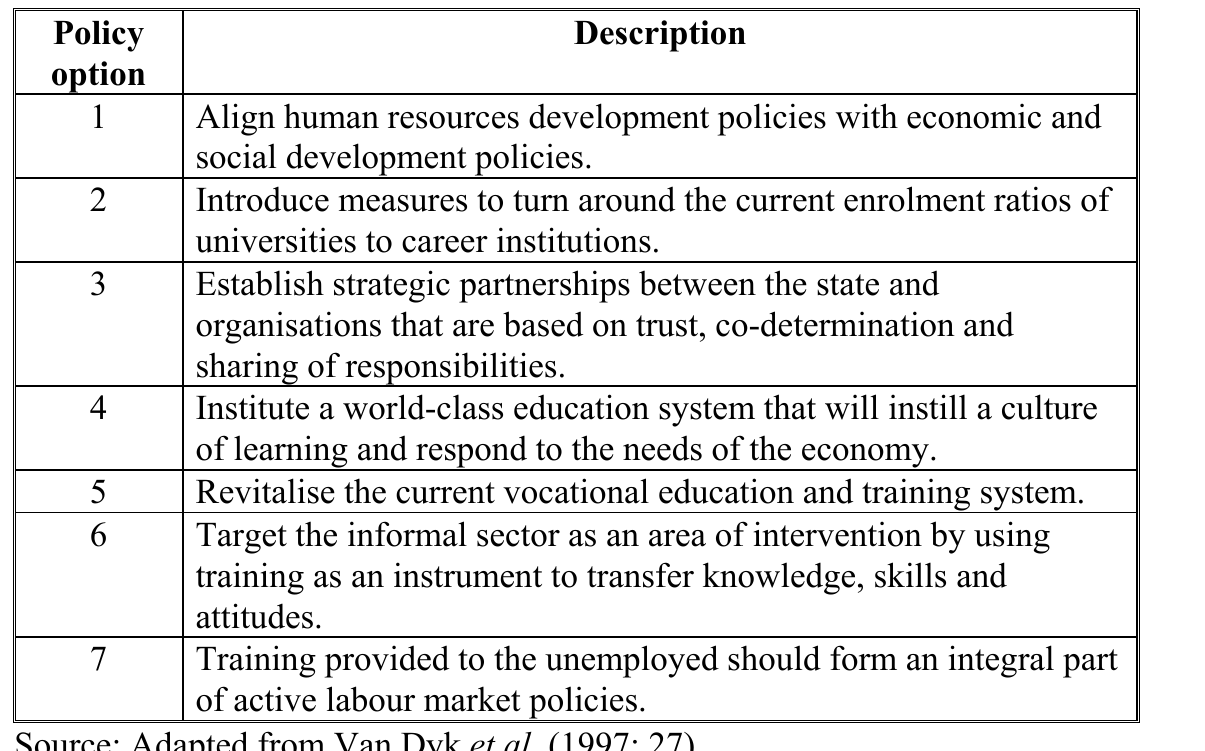
Possible training policy options for South Africa Policy option